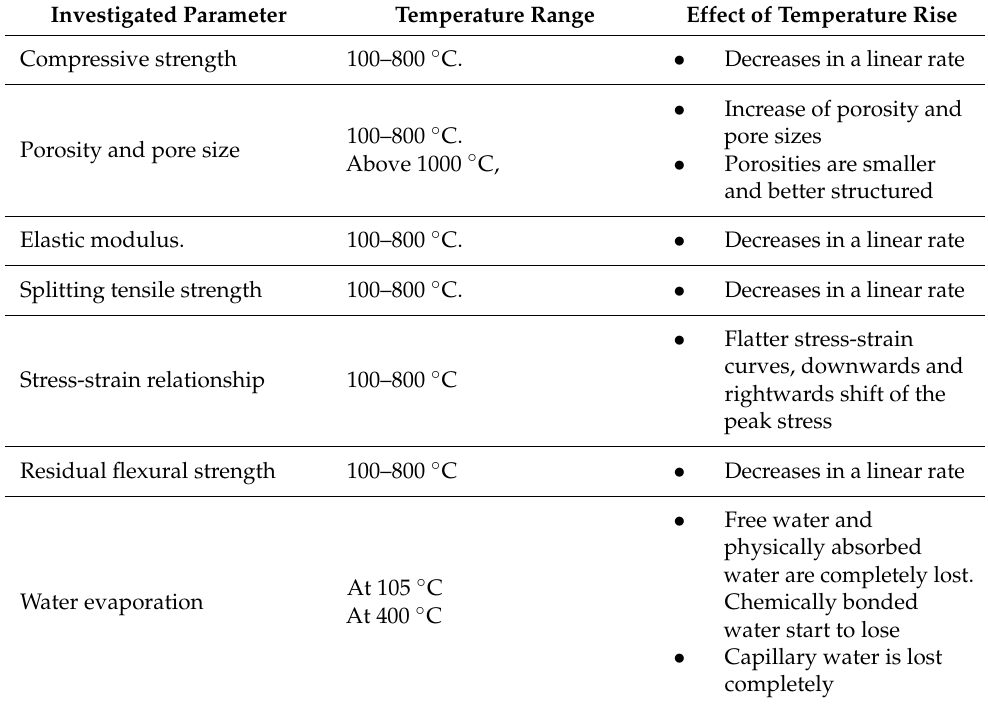
Table 2. The changes in physical and chemical parameters of concrete due to exposure to elevated temperature (data are exploited from